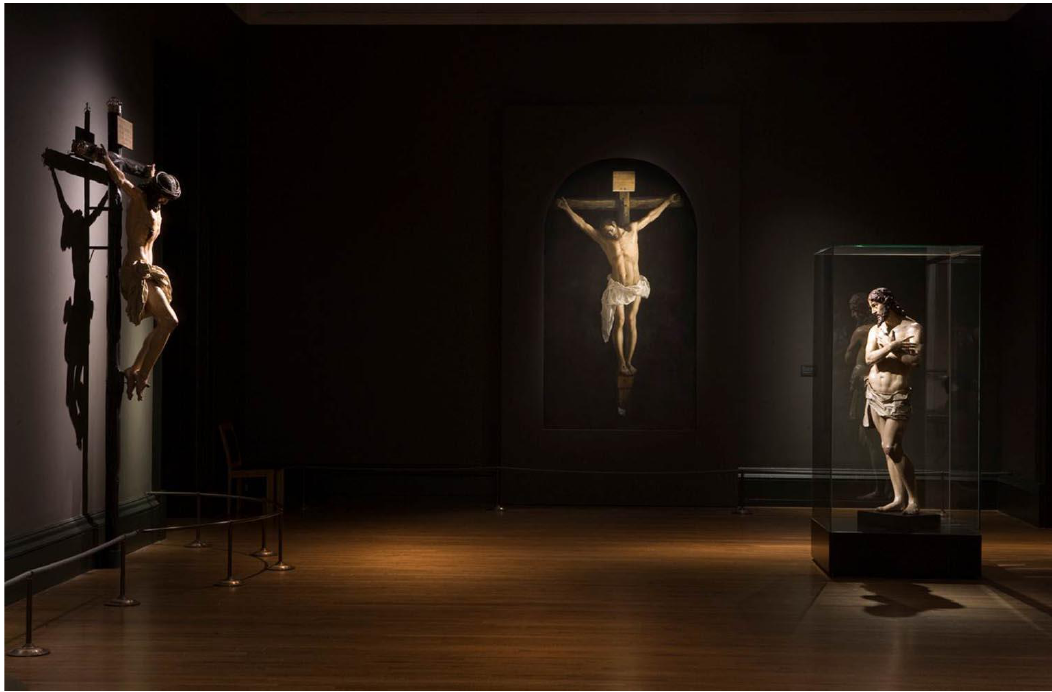
Figure 7. Installation shot of the Sacred Made Real exhibition at National Gallery, Courtesy of the National Gallery.